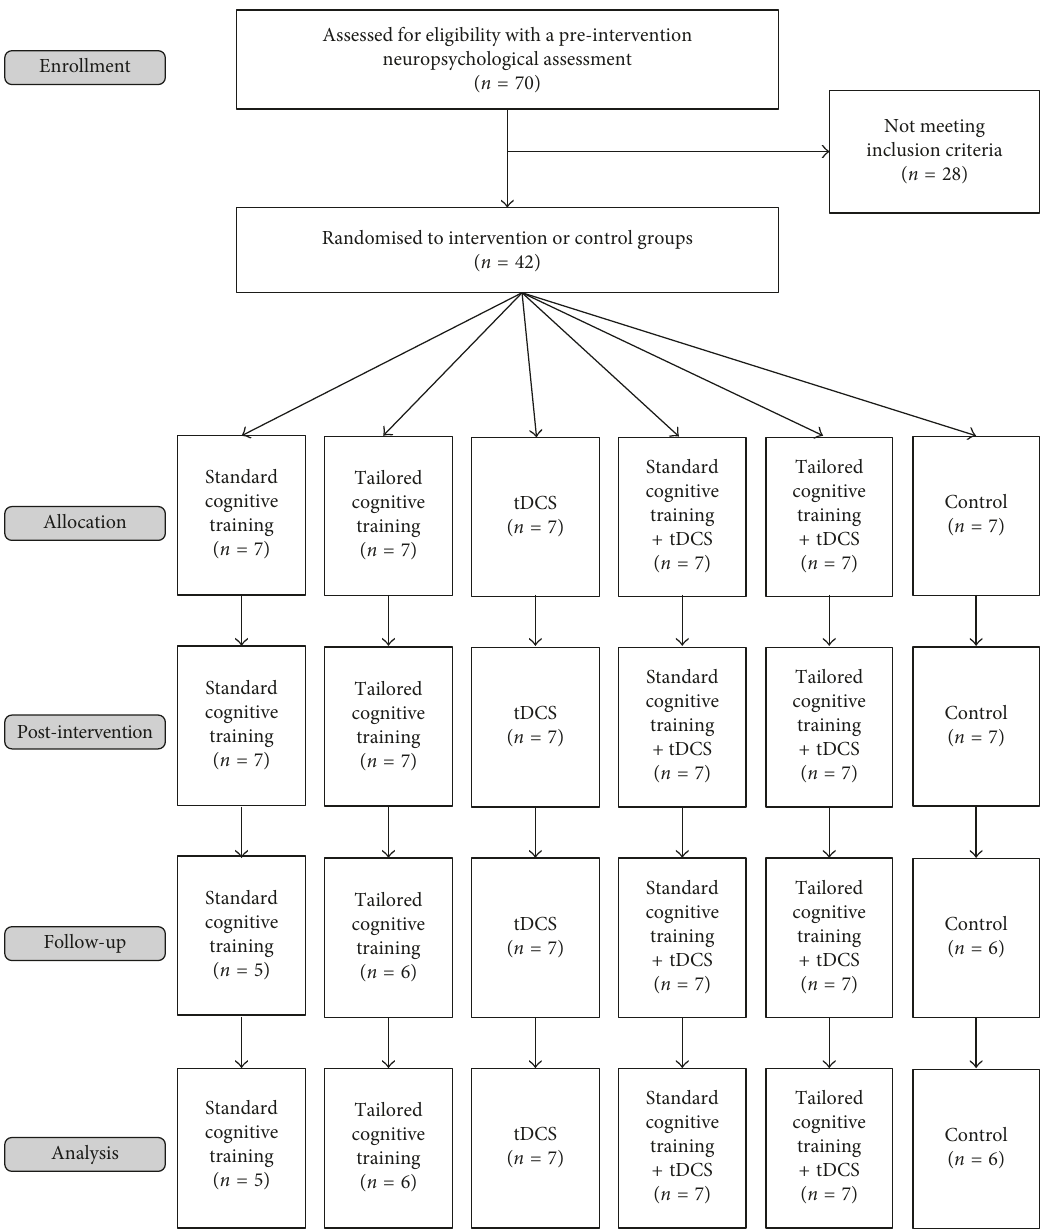
Figure 1: CONSORT flow